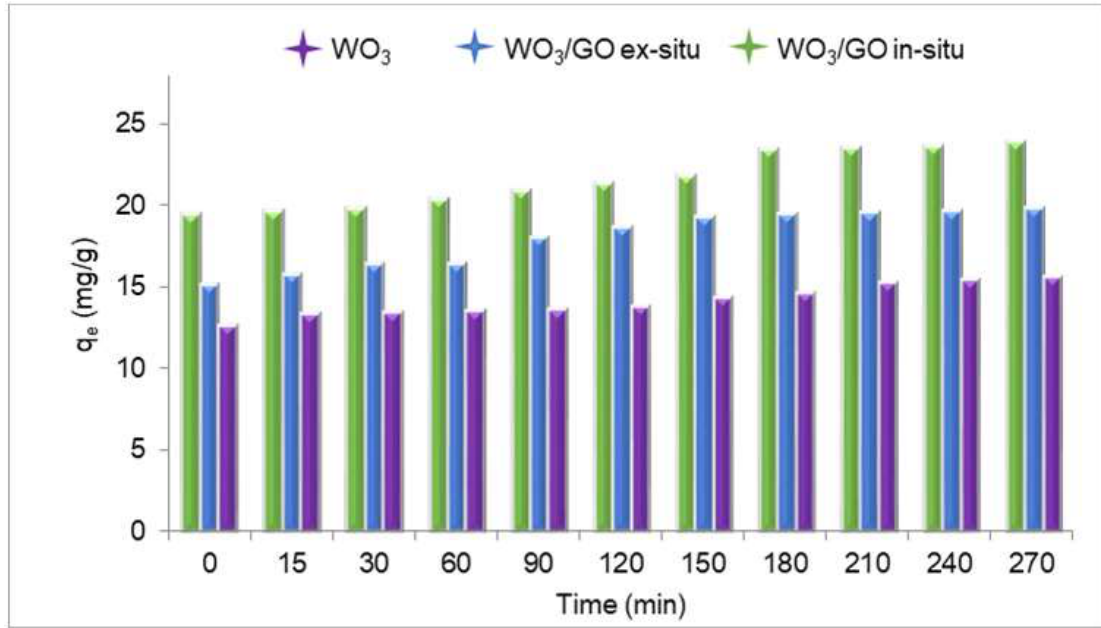
Figure 7. Relationship between adsorption capacity and